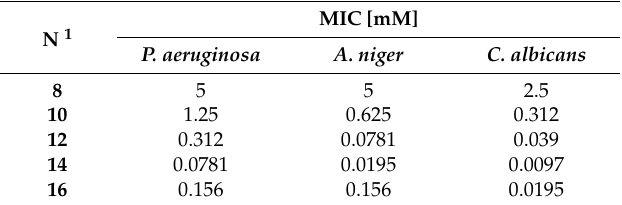
Table 4. Literature values of MIC of benzalkonium chlorides [42].